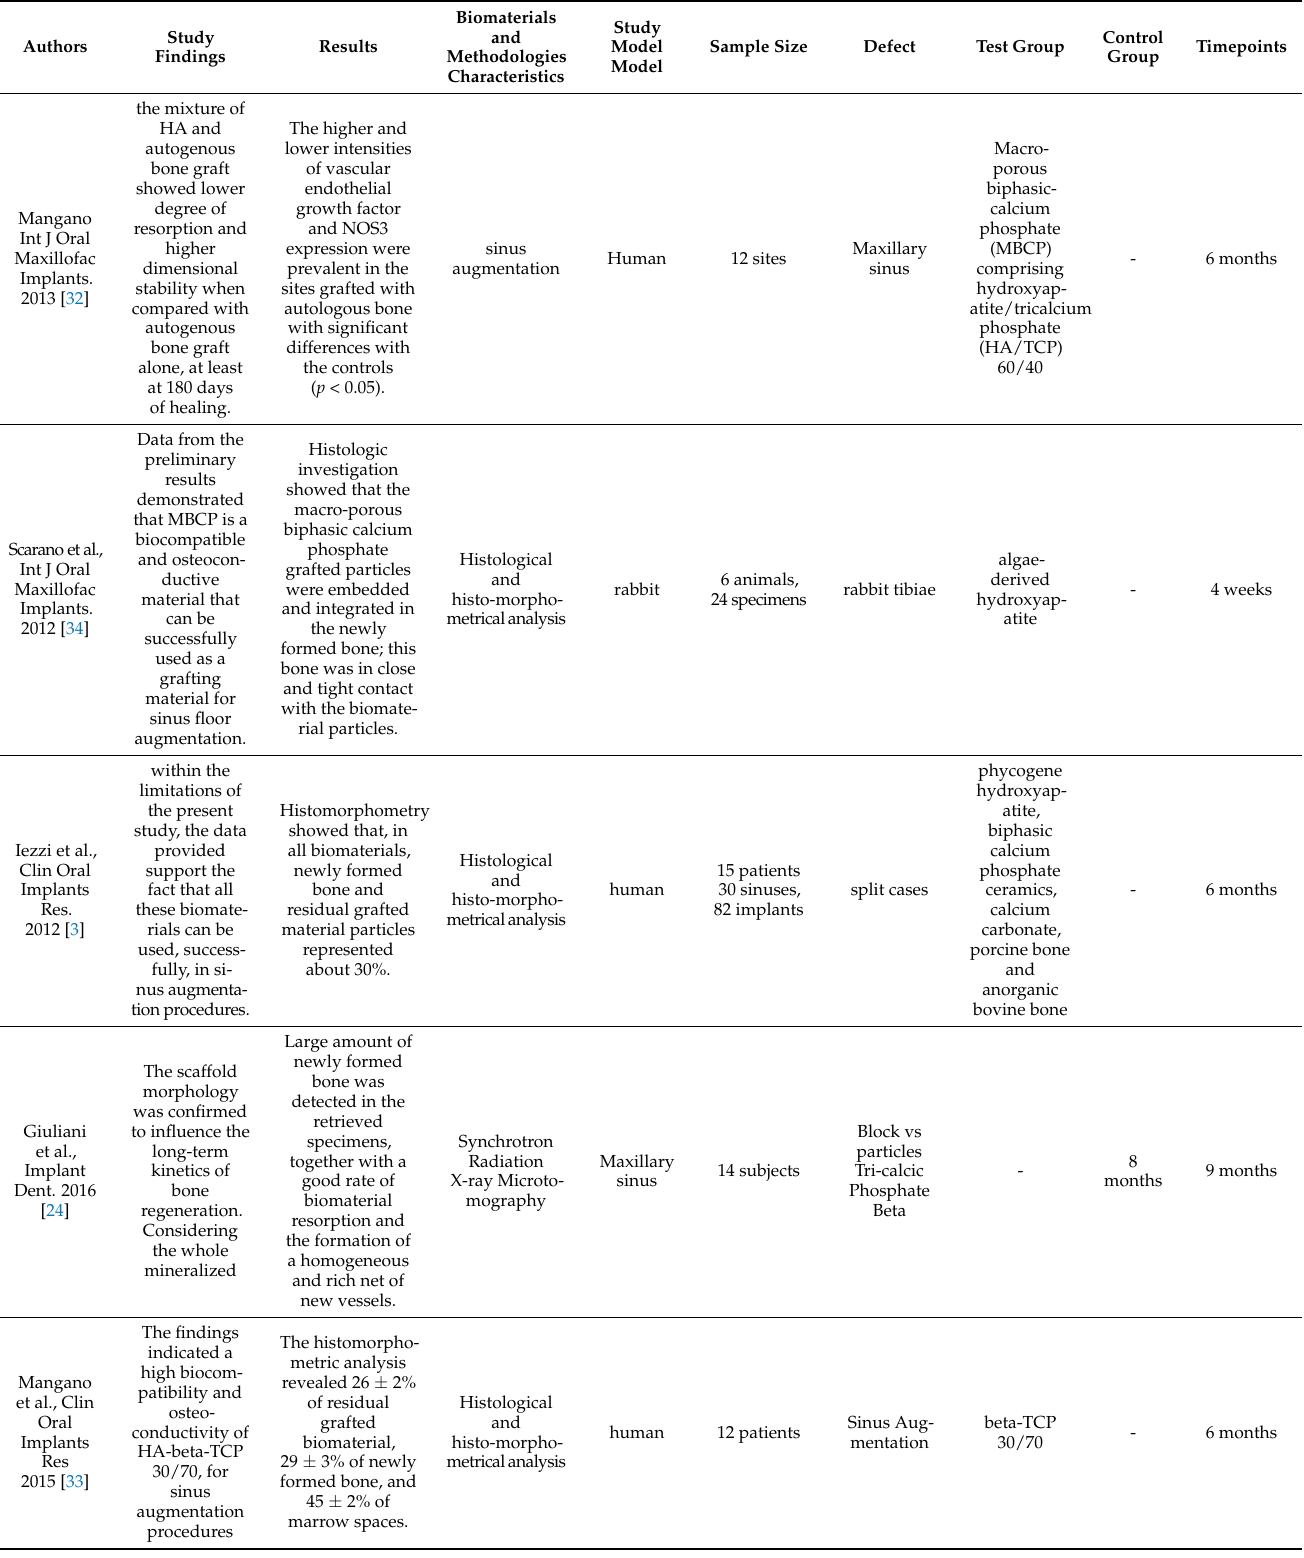
Table 4. Summary table of the Biphasic calcium phosphate (BCP) and Beta Tri-calcic Phosphate (Beta-TCP) findings of the papers